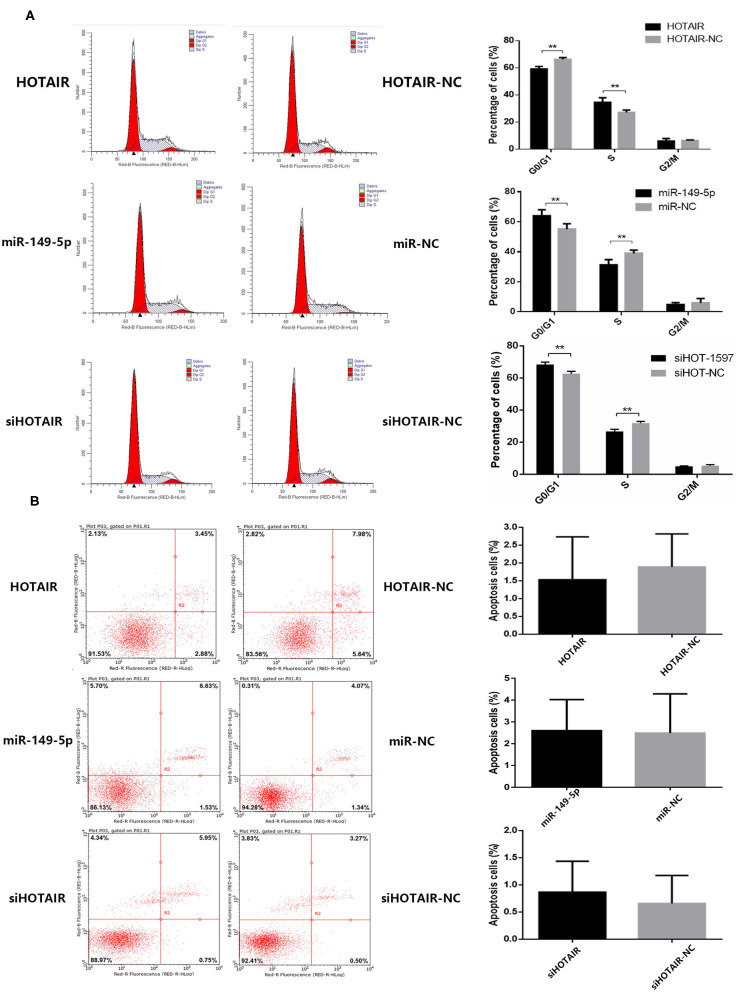
(A) Flow cytometry analysis of cell cycle distribution of lung cancer cells transfected with HOTAIR, miR-149-5p, and siHOTAIR. HOTAIR-transfected A549 cells show a decreased percentage of G0/G1-phase cells and increased S-phase cells (p < 0.05). miR-149-5p-transfected SPC-A-1 cells show an increased percentage of G0/G1-phase cells and decreased S-phase cells (p < 0.05). siHOTAIR-transfected SPC-A-1 cells show an increased percentage of G0/G1-phase cells and decreased S-phase cells (p < 0.05). (B) Flow cytometry analysis of apoptosis of lung cancer cells transfected with HOTAIR, miR-149-5p, and siHOTAIR. HOTAIR, miR-149-5p, or siHOTAIR have no effect on percentage of apoptosis apoptotic lung cancer cells (p > 0.05). **P < 0.05.